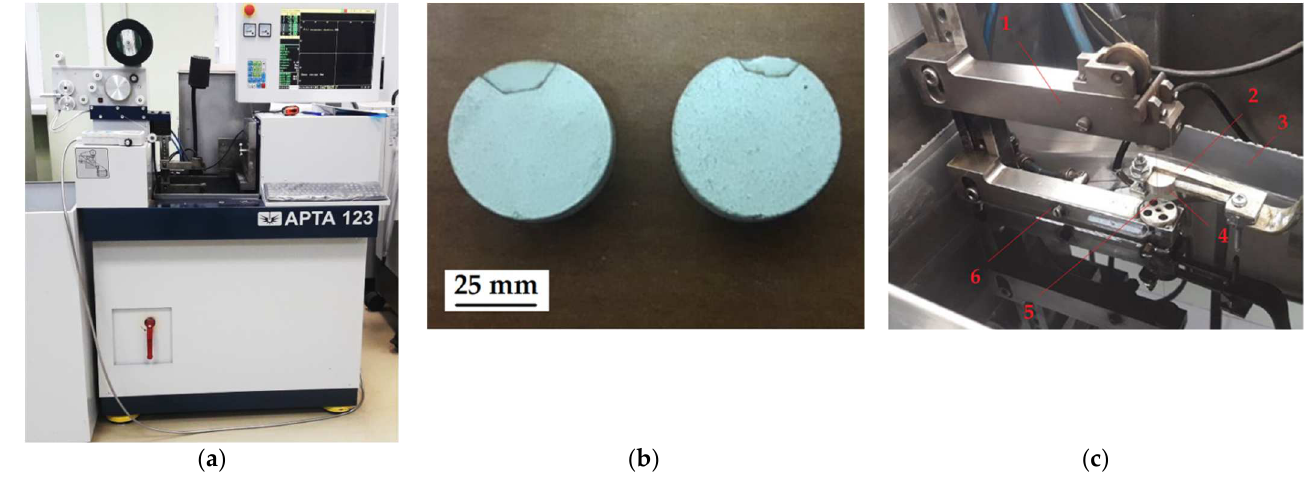
Figure 2. ( a ) Wire electrical discharge machine ARTA 123 Pro (common view); ( b ) coated samples; ( c ) installation of the coated Al 2 O 3 sample at working area of the machine, where 1—upper guide, 2—holder, 3—replaceable work tank; 4—a coated workpiece; 5—a rewinding wire tool; 6—a lower guide. Table 3. Main characteristics of wire electrical discharge machine ARTA 123 Pro.